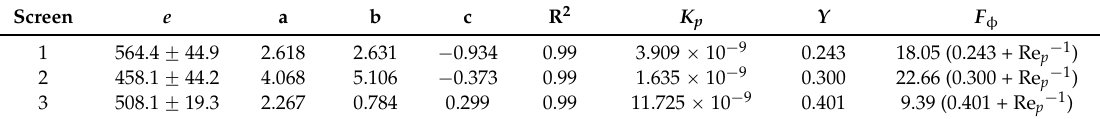
Figure 3. Pressure drops Δ P (Pa) measured in the wind tunnel experiments ( a ) and pressure drop coefficient due to the insect-proof screen F φ ( b ) in function of air velocity through screen u s (m·s − 1 ) and its reciprocal 1/ u s , respectively. Theoretical ( c ) and statistical ( d ) relationships between the discharge coefficient due to the insect-proof screen C d, φ and u s . Insect-proof screens 1 ( Δ ), 2 ( □ ) and 3 ( ◊ ); values of C d, φ for air velocity equal to 0.25, 0.5 and 1.0 m·s − 1 ( ▲ , ■ , ♦ ). Table 3. Aerodynamic characteristics of the insect-proof screens installed in the experimental greenhouse. e , thickness of the insect-proof screen ( µ m); a, b and c are the coefficients of the polynomial fit of the wind tunnel experiments; R 2 , coefficient of determination; K p , screen permeability (m 2 ); Y , inertial factor; F φ , pressure drop coefficient that depends on the Reynolds number based on the permeability of the insect-proof screen Re p